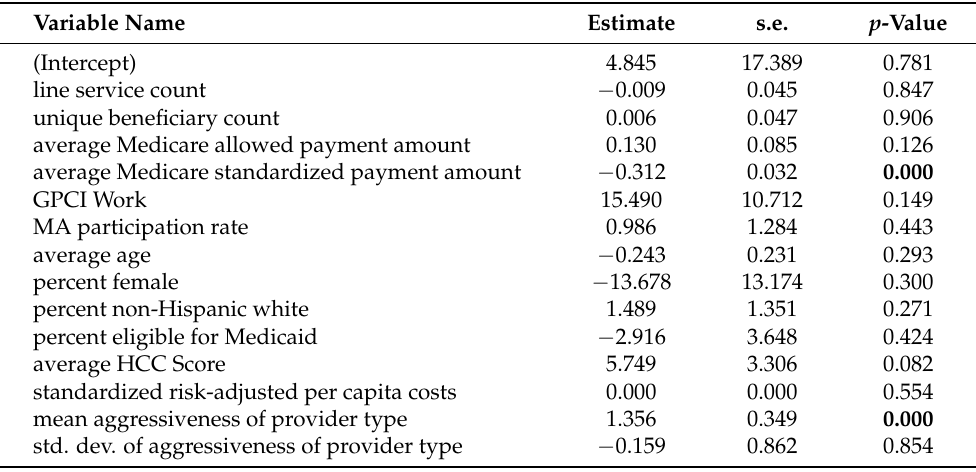
Table 2. OLS regression statistics where billing aggressiveness for Procedure 77055 is the depen- dent